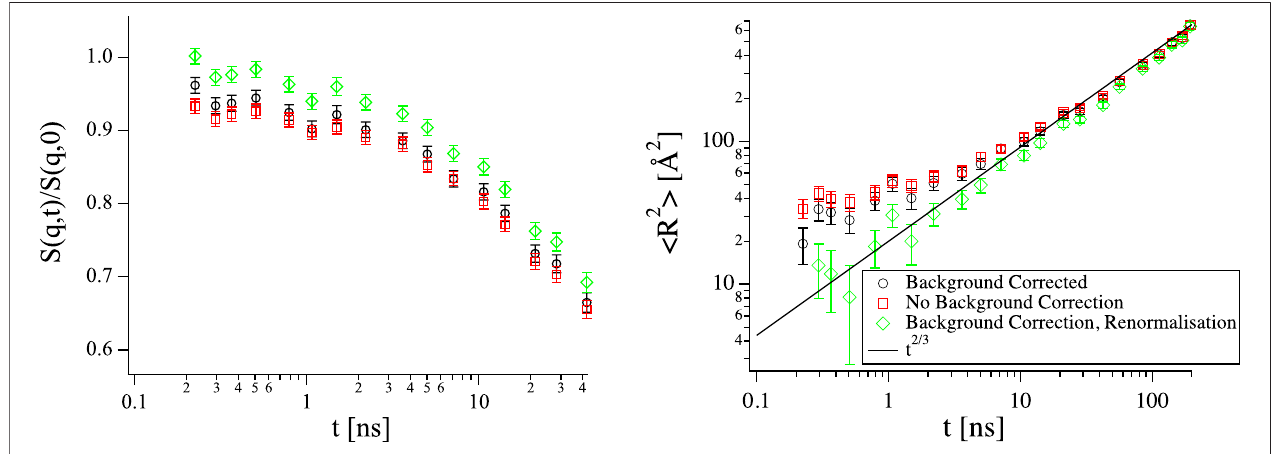
FIGURE 9 | Left: Short timerange of S ( q , t ) from the same vesicle sample as in Figure 4 at q (cid:2) 0.11 1/Å with logarithmic x -axis, the same color code as in the right hand panel applies. Right: Mean square displacement calculated from the curves on the left. The black line shows scaling with t 2/3 as expected for the Zilman-Granek model. The Background corrected sample does not exactly go up to one at short times (left) . As a result a scaling with low scaling exponent x appears at short times in 〈 R 2 〉 (right) . Thisbehaviordisappears when bruteforcerenormalizingthe curve withafactor 1/0.96 which ensures thatthecurve startsat 1 (left) and 〈 R 2 〉 scales as t 2/3 even at the shortest time (right)